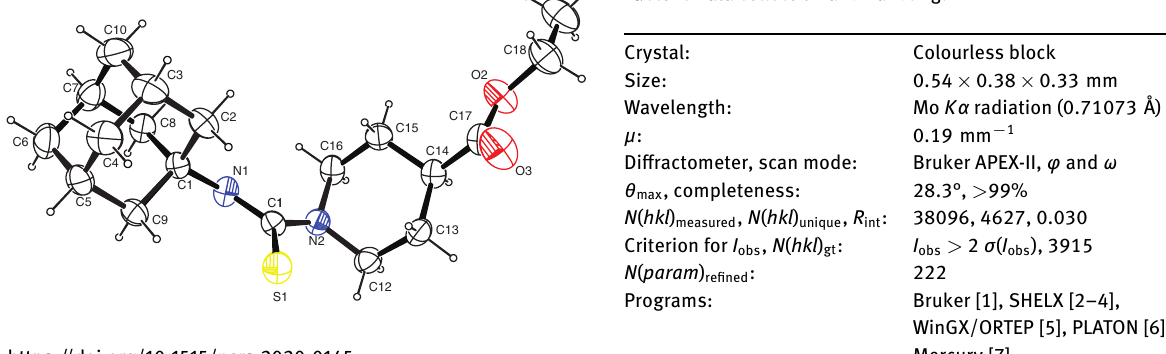
Table 1: Data collection and handling.